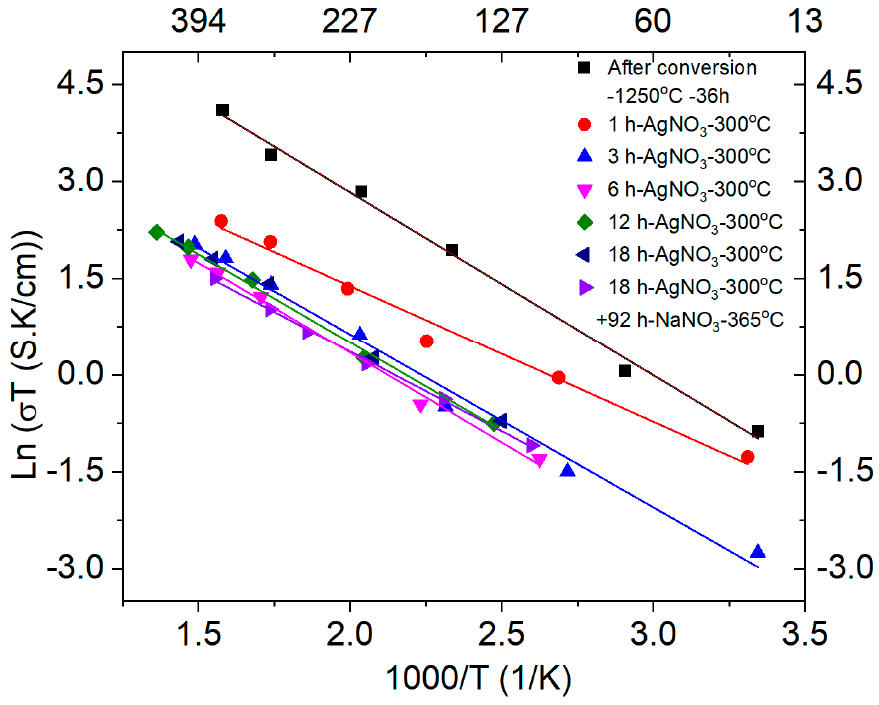
Figure 8. Arrhenius plots of the measured conductivity of the as fabricated sample and after successive silver ion exchange.